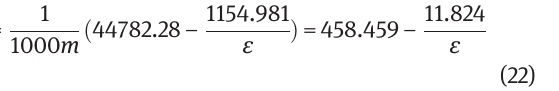
Table 2 gives the values of Q at different strain. It can be found that the values of Q obtained from eq. (22) and Ref [4] have little variation.